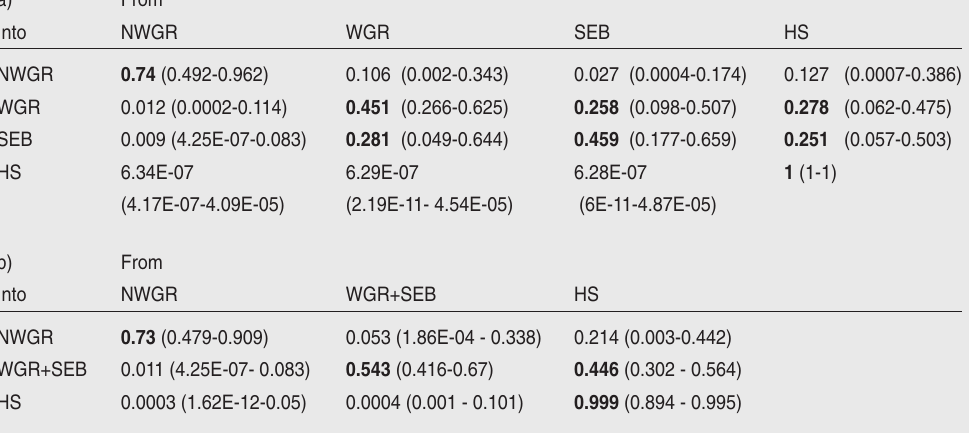
Table 4. Recent migration rates and directions between the four walrus areas based on the estimates of means a) keeping the areas separate and b) after pooling West Greenland (WGR) and Southeast Baffin Island (SEB). Figures in parentheses=highest posterior density intervals (HPDI) (BIMr, (Faubet and Gaggiotti 2008). NWGR=Northwest Greenland, HS=Hudson